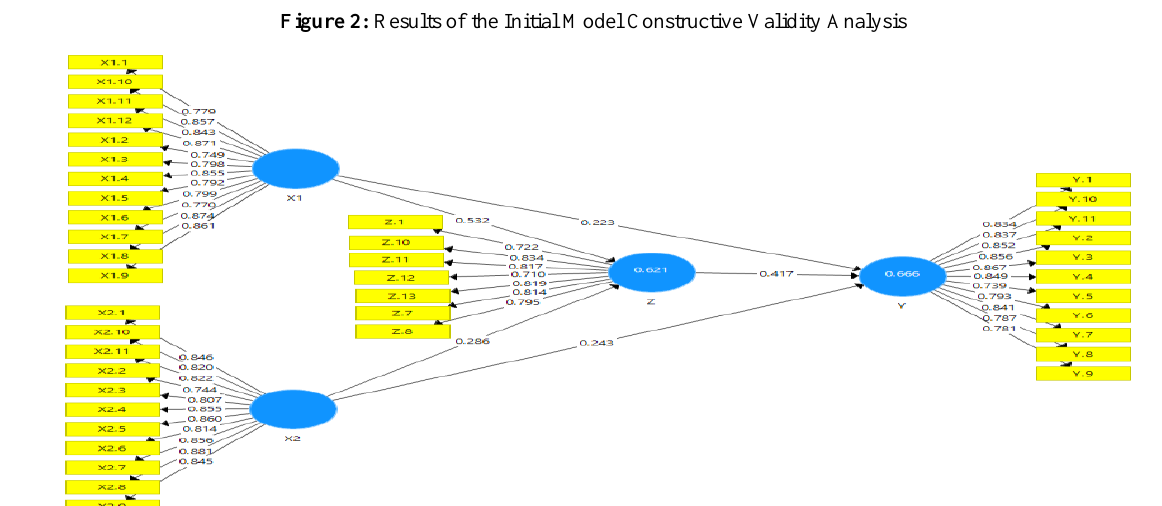
Figure 2: Results of the Initial Model Constructive Validity Analysis